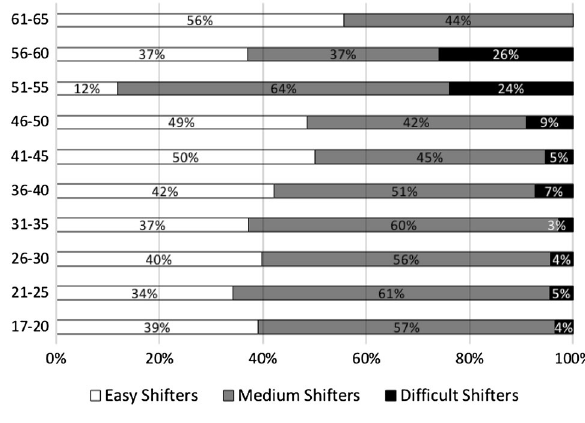
Fig. 4 Metro shifters’ age categories